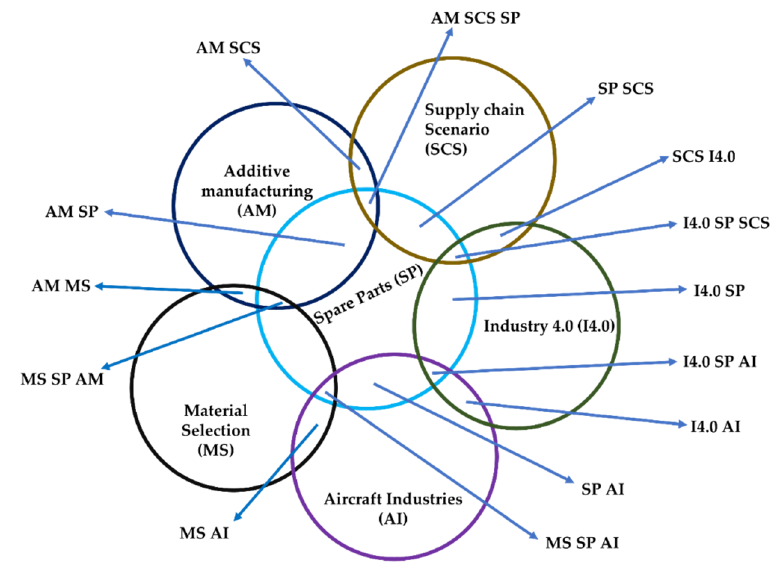
Figure 1. Framework of Core Subject Areas Mapping.